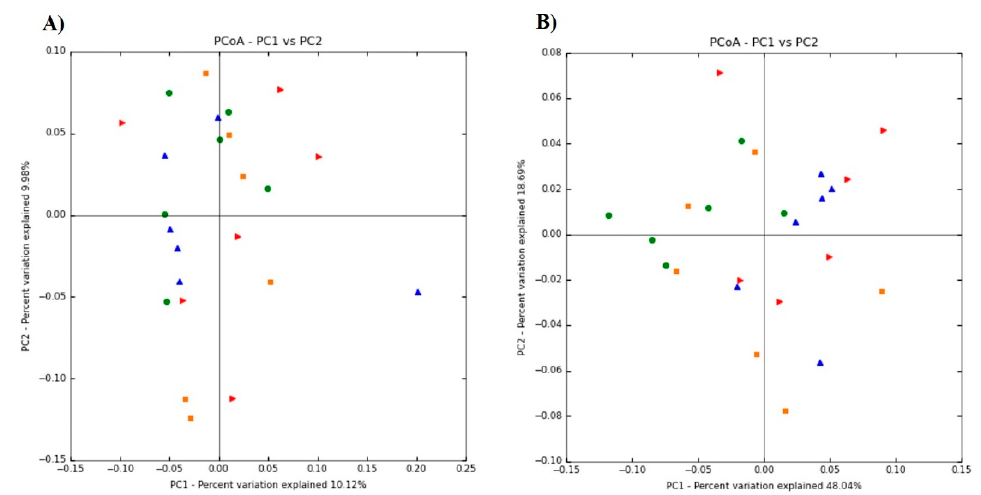
Figure 4. The composition changes of cecum microbiota based on principal coordinate analysis (PCoA) including unweighted ( A ) and weighted ( B ) unifrac distances in the dietary steam-exploded pine particles (SPP) supplemented chickens kept at either thermoneutral or at heat-stress. The treatments were control diet containing 0% SPP at thermoneutral temperature (0% NT), control diet with acute heat stress (0% HS), 1% SPP-supplemented diet at acute heat stress (1% HS), and 2% SPP-supplemented diet at acute heat stress (2% HS). The thermoneutral birds were maintained at 21.0 °C while the temperature of the heat-stressed room was raised to 31 °C within the first three hours and then maintained for another three hours that makes the total HS period of six hours. The red triangle indicates 0% NT, the blue triangle indicates 0% HS, the orange square indicates 1% HS, and the green circle indicates 2% HS treated chickens.